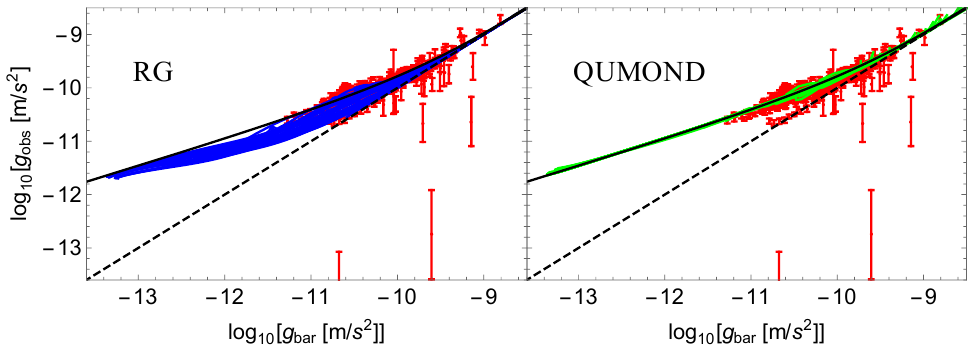
Figure 7. The RAR built in RG ( left panel , blue solid lines) and in QUMOND ( right panel , green solid lines) for DMS galaxies. The RG and QUMOND models are superimposed onto the observed RAR of DMS galaxies (red dots with error bars). Equation (3) (black solid line) and the g obs = g bar line (black dashed line) are shown as a reference. The figure is taken from Figure 11 in [45].